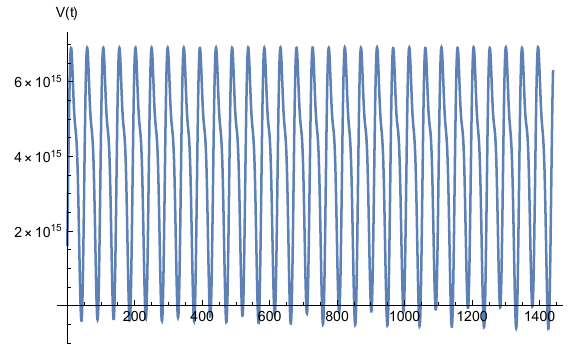
Fig. 5 Visibility Intervals Between HST and ODIN For 24-H